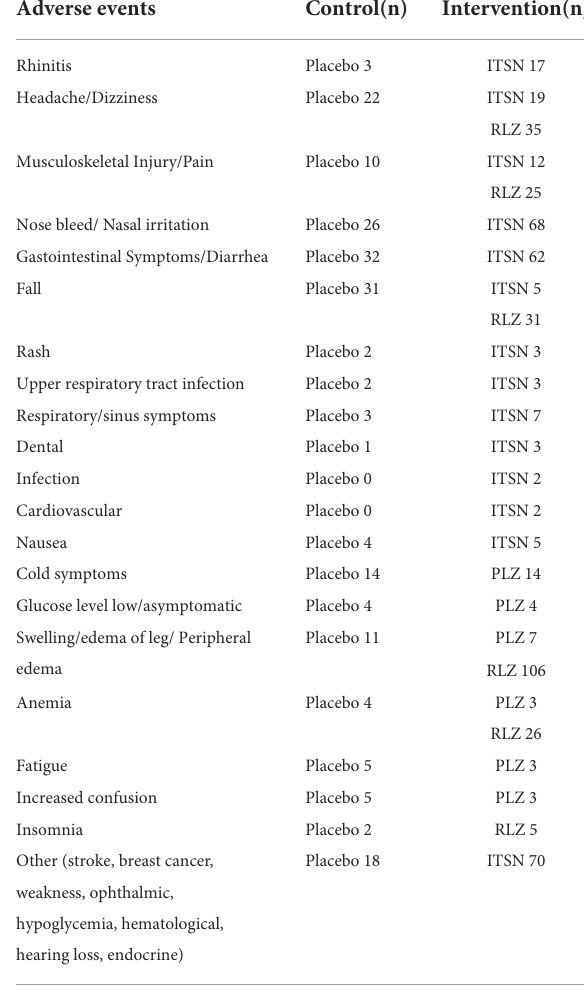
TABLE 5 Adverse events included in the